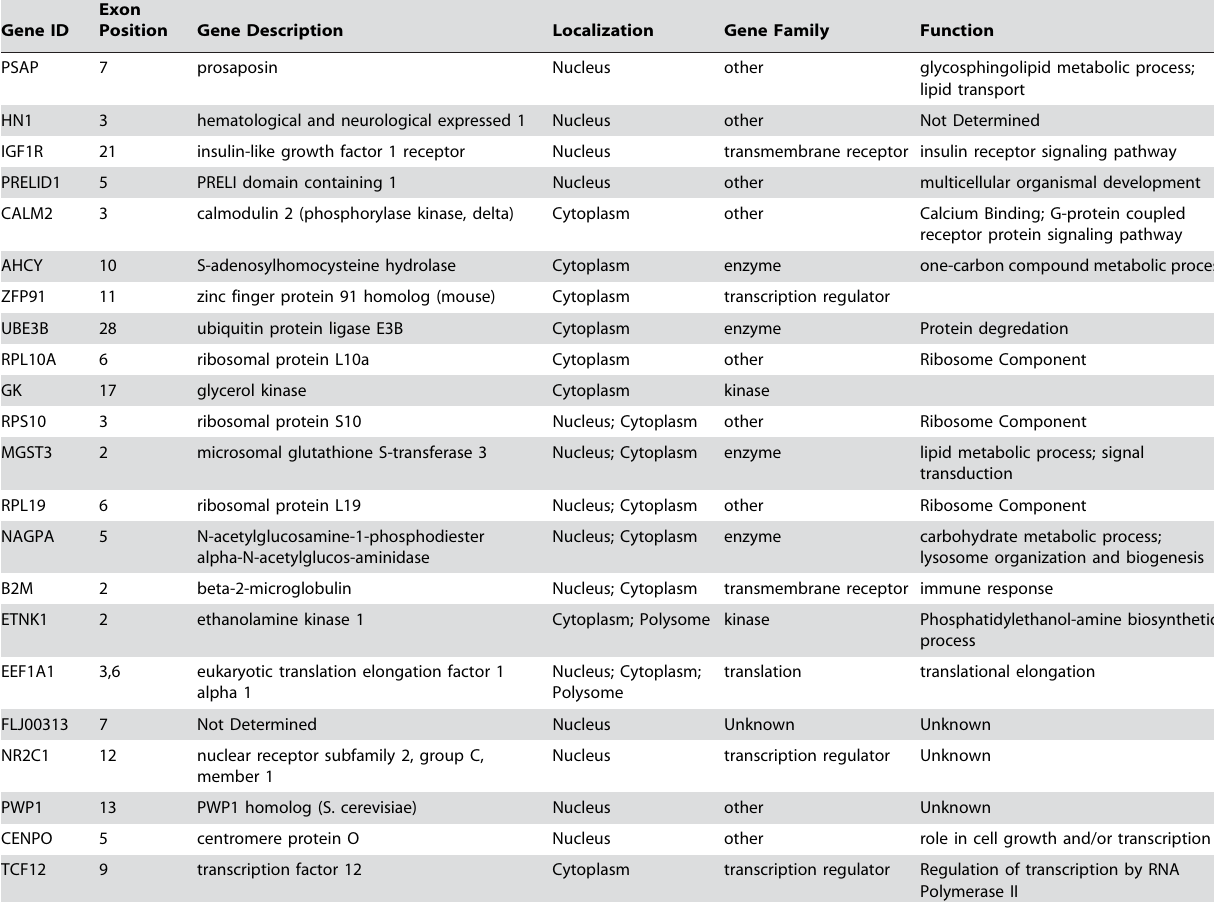
SF2/ASFtargetexonscontainingalternative3 9